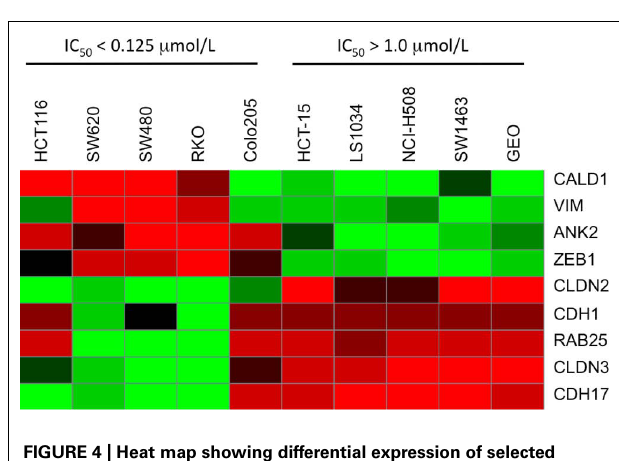
FIGURE 4 | Heat map showing differential expression of selected genes involved in EMT compared to sensitivity to PF-3758309.